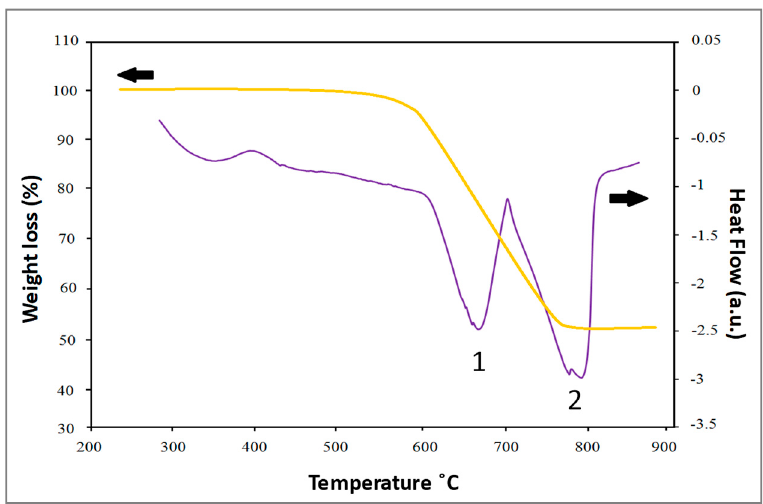
Figure 2. Thermogravimetric analysis (TGA)–differential scanning calorimetry (DSC) curves of Figure2. Thermogravimetric analysis (TGA)–di ff erential scanning calorimetry (DSC) curves of dolomite dolomite decomposition and weight loss between 200 and 900 °C. decomposition and weight loss between 200 and 900 ◦ C.